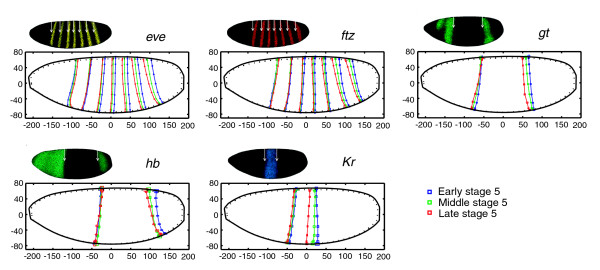
Movement of gap and pair rule stripe borders. Lateral orthographic projections of the mean positions of the anterior borders of eve and ftz stripes from early (4-8%) (blue), mid (26-50%) (green) and late (76-100%) (red) stage 5 cohorts, and of selected borders of gt, hb and Kr stripes from early (0-3%) (blue), mid (9-25%) (green), and late (51-75%) (red) stage 5 cohorts. The stages chosen for gap gene analysis were earlier than those for pair rule genes because, unlike pair rule mRNA, gap mRNA is rapidly down-regulated towards the end of stage 5, whereas pair rule expression increases throughout stage 5. The error boxes at each measurement point represent 95% confidence intervals for the mean in a/p and d/v directions. Anterior is to the left, dorsal is to the top. The x- and y-axes show the distance in μm from the center of embryo mass. It can be seen that most stripe borders changed spatial location during stage 5. The silhouettes of PointClouds were smaller for later stage embryos because of basal nuclear movements. Note that, for each eve and ftz stripe, the posterior stripe border shows a broadly similar movement to the anterior border, indicating that the movements observed are not principally due to the narrowing of stripes (data not shown).